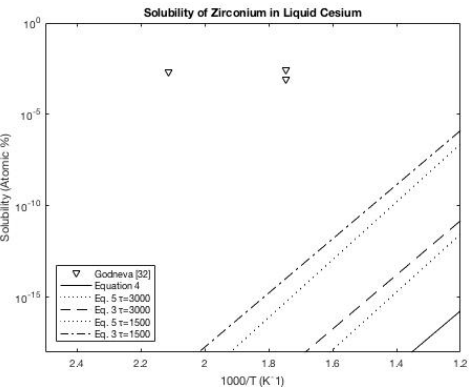
Figure A5. Solubility of additional transitional metals in liquid cesium compared to the model.